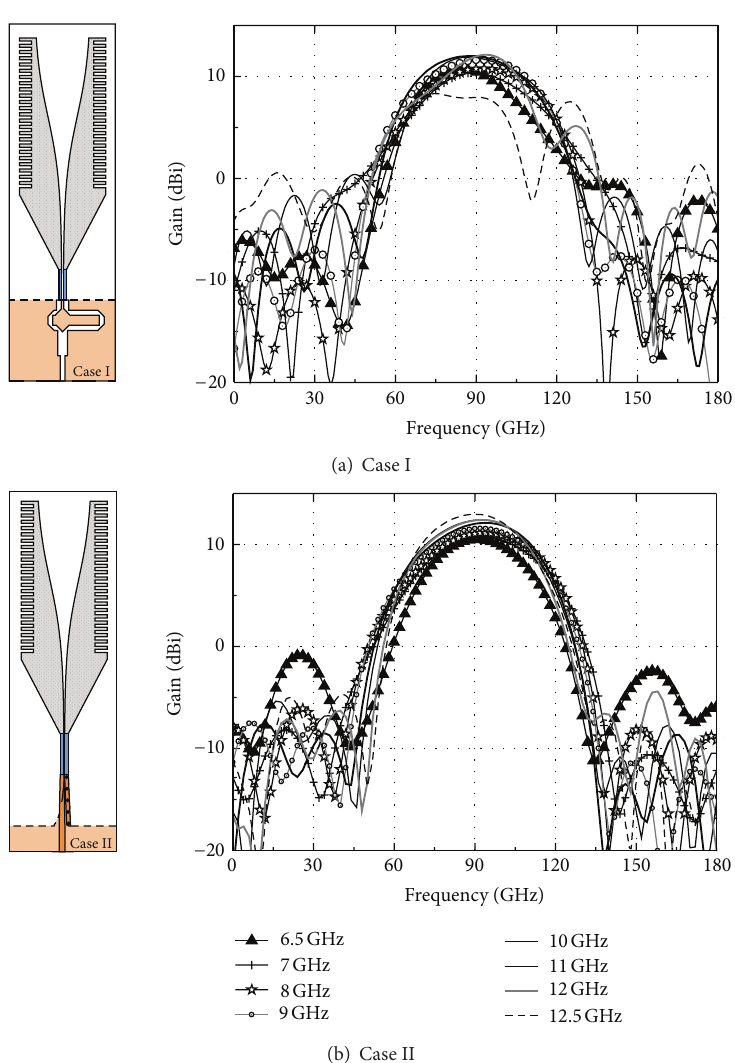
Figure 6: E-plane radiation patterns of TSAs